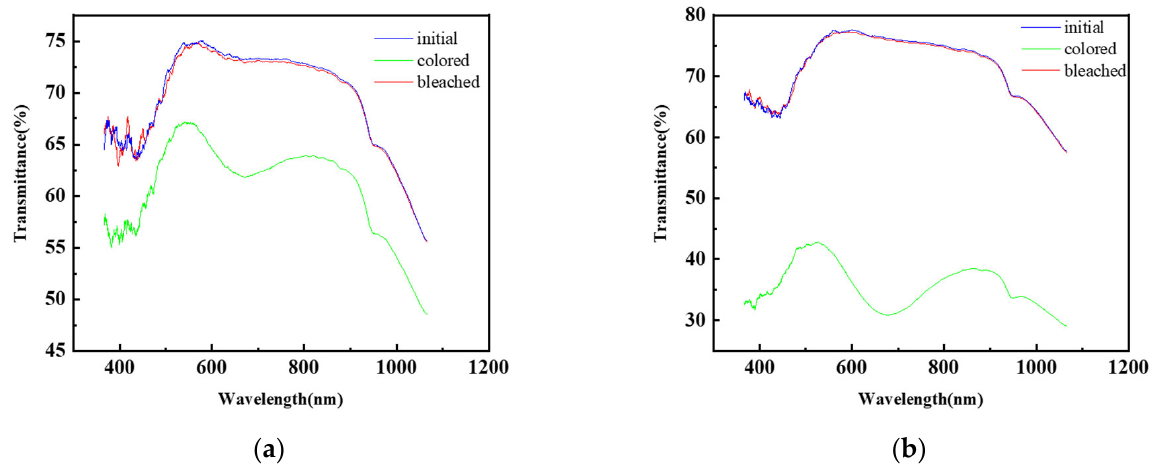
Figure 4. The optical transmittance spectra of the two different samples of the mixed functional layer in the initial, bleached, and colored state: ( a ) 0.175 mol/L ammonium metatungstate × 0.25 mol/L iron (II) chloride group at a current density of 1 A/m 2 ; ( b ) 0.175 mol/L ammonium metatungstate × 0.20 mol/L iron (II) chloride group at a current density of 5 A/m 2